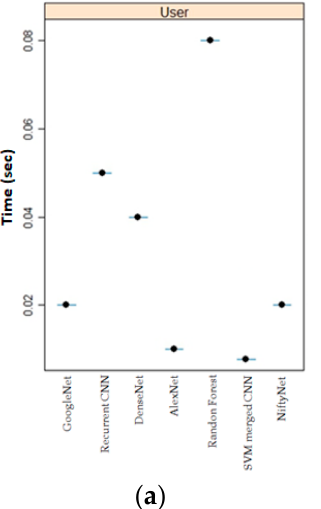
Figure 5. An intercomparison of time complexity for different classification algorithms.